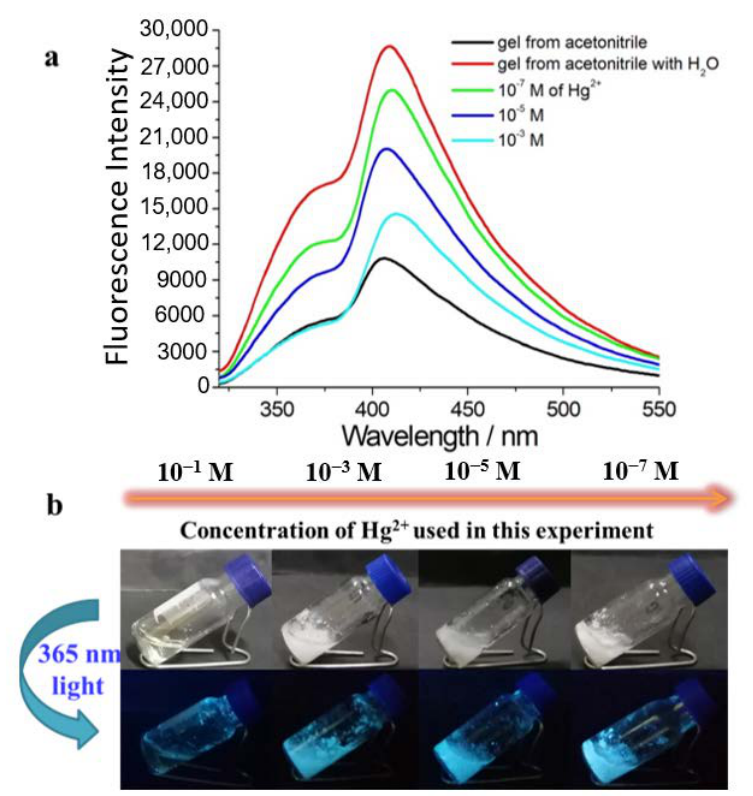
Figure 10. ( a ) Fluorescence emission spectra of gels of 1 after the addition of Hg 2+ aqueous solution with the different concentrations; ( b ) the changes in gel state and emission light for gels of 1 after the addition of Hg 2+ aqueous solution with the different concentrations. The addition amount of Hg 2+ aqueous solution was 70 µ